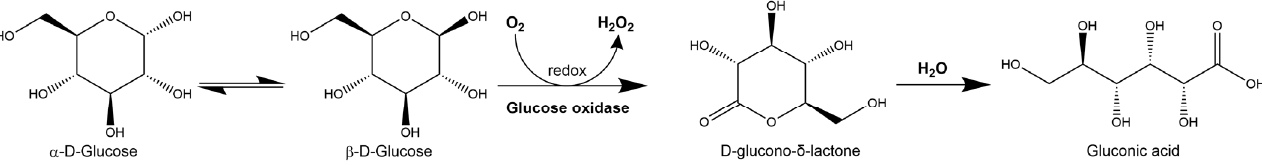
Figure 3. Schematic representation of the enzymatic reaction between glucose oxidase and glucose to produce H 2 O 2 and gluconic acid.